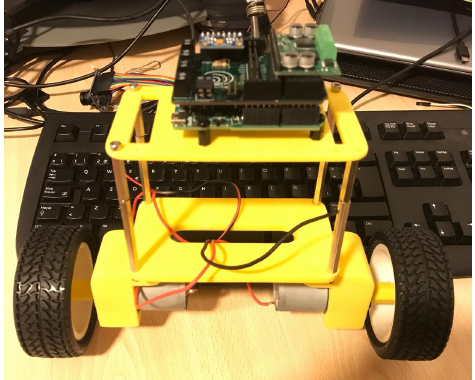
Figure 20. Final results of Self-Balancing